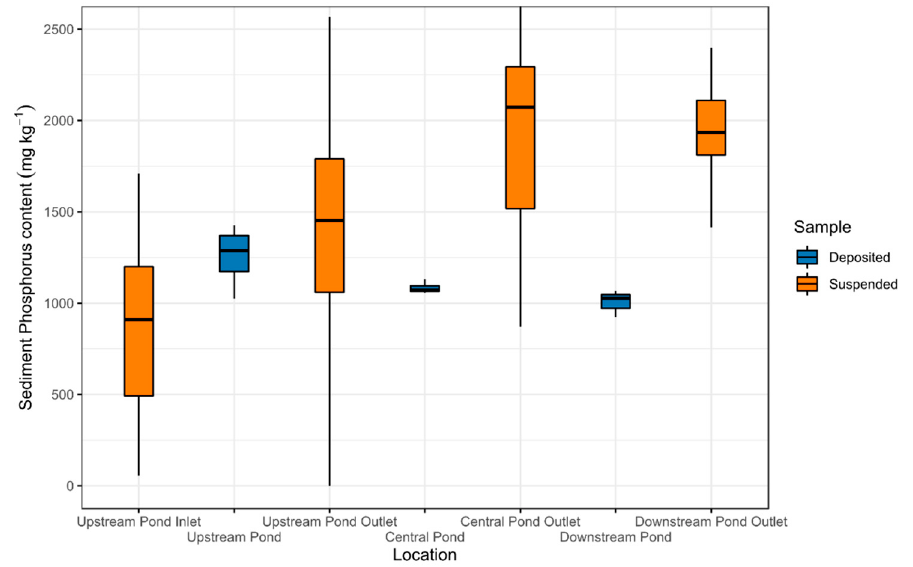
Figure 9. Boxplots showing the range of sediment phosphorus content (mg kg − 1 ) at different locations along the on-line pond system. Deposited samples were from sediment traps deployed during March 2019, and suspended samples from water sampled during the storm event in the same month. Median values are represented by bold lines.